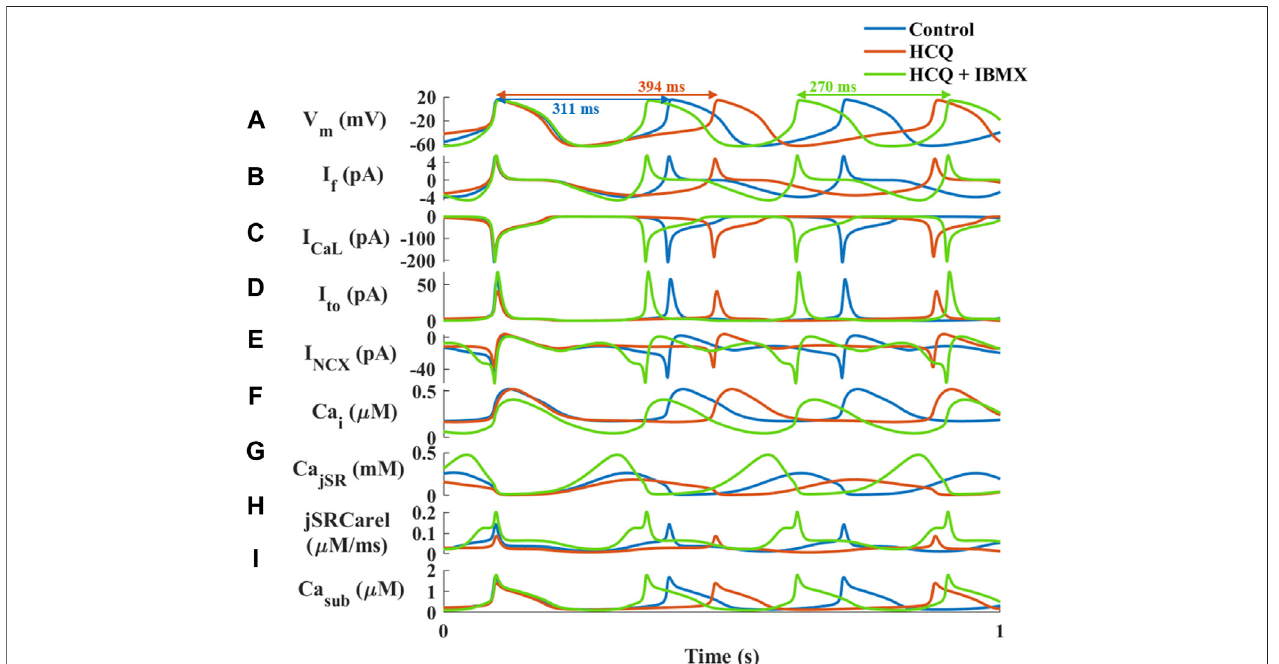
FIGURE 6 | Major currents and Ca 2+ cycling in simulated rabbit sinoatrial node cells in response to 1 μ M hydroxychloroquine (HCQ) and 10 μ M isobutylmethylxanthine (IBMX) treatment. Coupled-clock function of control (blue), and of HCQ- (yellow) or HCQ + IBMX-treated (green) rabbit sinoatrial node cells. (A) Membrane voltage (V m ) and representative beat intervals, (B) I f , (C) I CaL , (D) transient potassium current (I t0 ), (E) Na + -Ca 2+ exchanger current (I NCX ), (F) intracellular Ca 2+ concentration (Ca i ), (G) Ca 2+ concentration in the junctional SR compartment (Ca jSR ), (H) fl ux of Ca 2+ exiting the SR (j SRCarel ) and (I) Ca 2+ concentration in the subspace (Ca sub